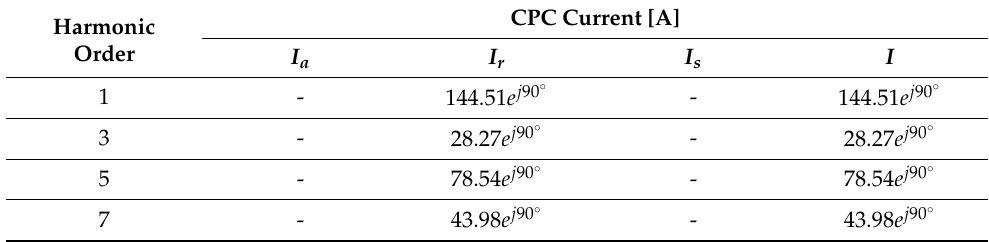
Table 8. List of complex values of currents in CPC theory.